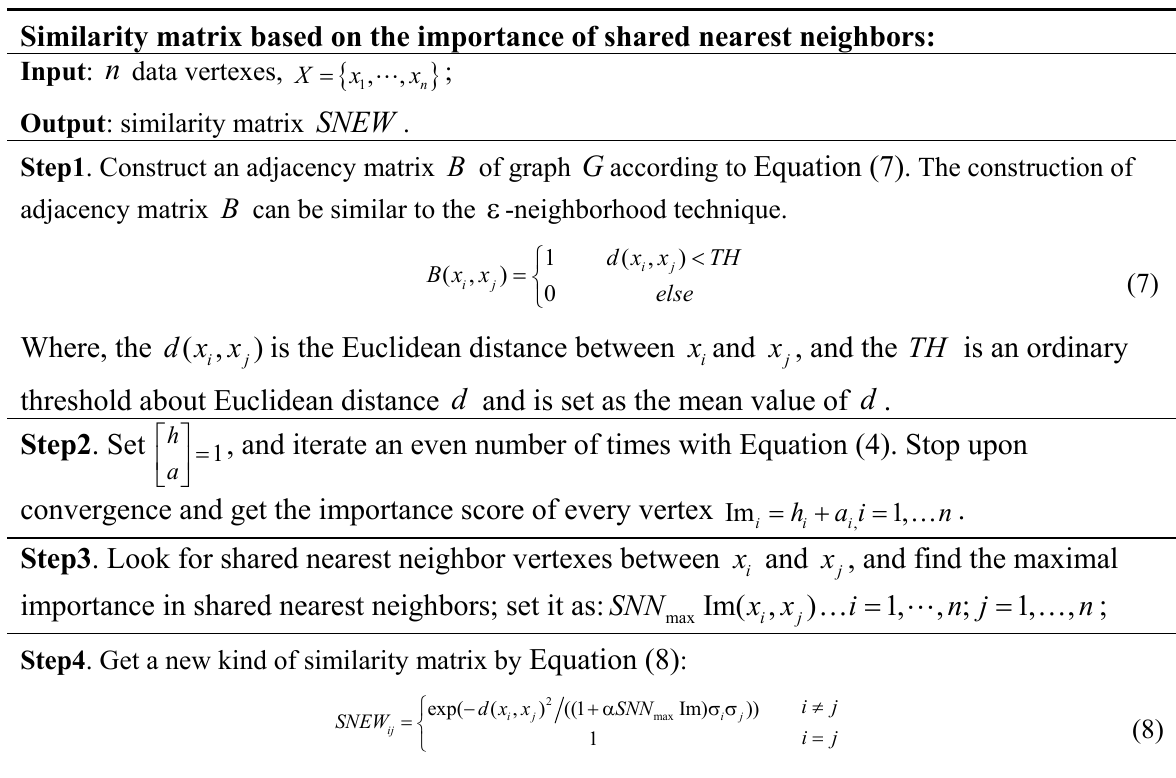
Table 1. The algorithm of similarity matrix based on the importance of shared nearest